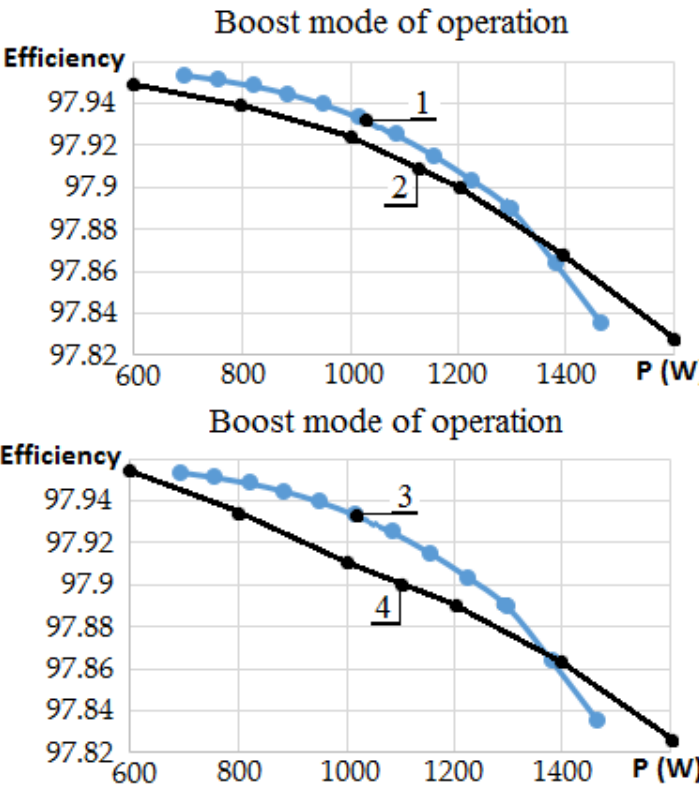
Figure 19. Comparison between analytically 1 and 3, and experimentally 2 and 4 estimated efficiency, according to Figures 7 and 9.